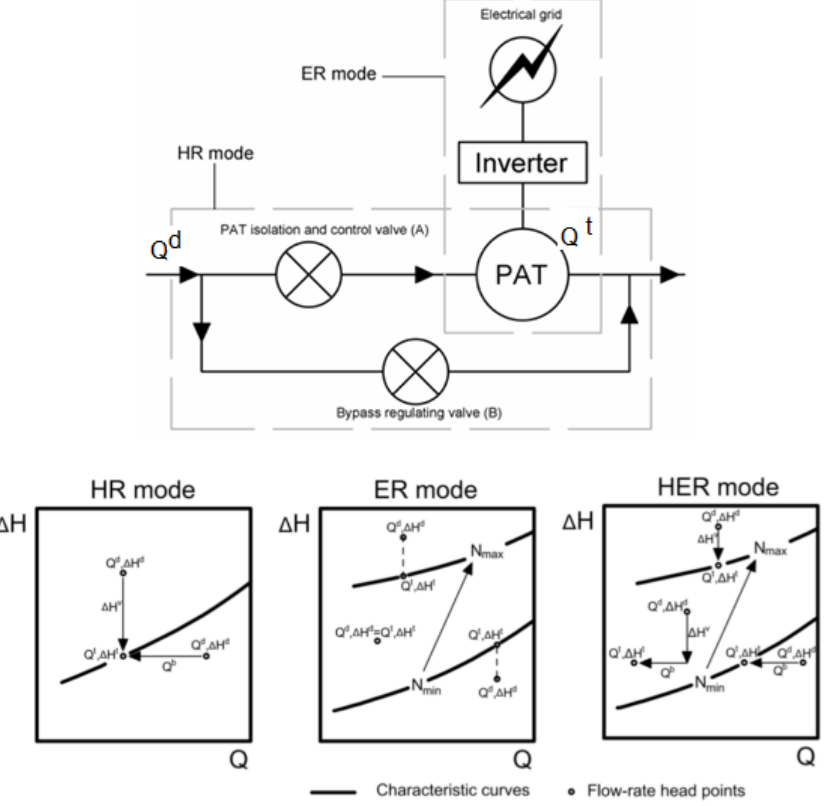
Figure 1. Hydraulic regulation (HR), Electrical regulation (ER) and (Hydraulic-Electrical regulation (HER) modes.